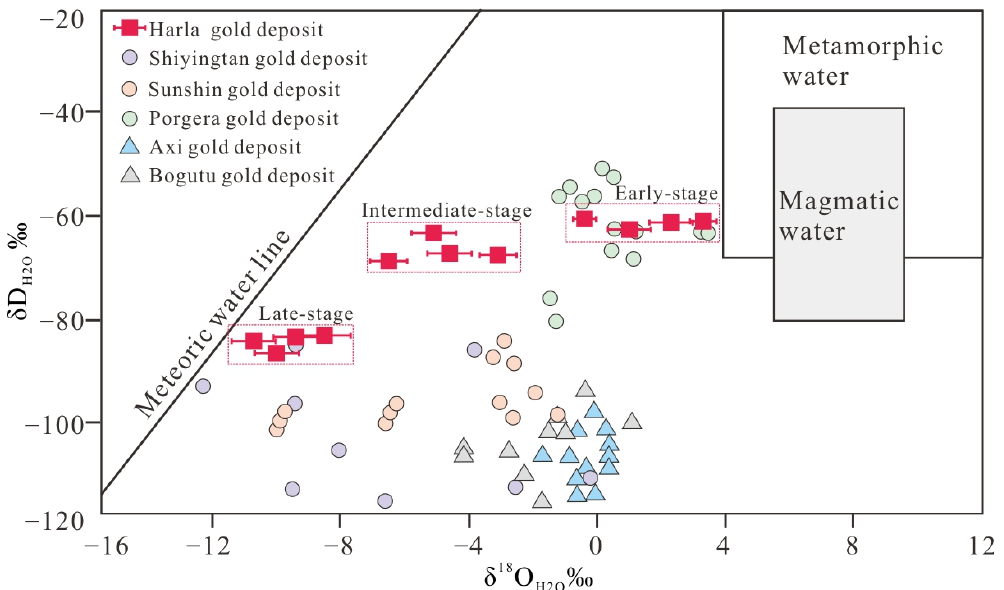
Figure 8. δ D H2O vs. δ 18 O H2O plot for FI water from different stages of the Harla gold deposit compared with other typical gold deposits. Fields for magmatic water, metamorphic water, and meteoric water line are from Taylor [25]. Data for other gold deposits are from Zhang et al. [26], Kim et al. [27], Ronacher et al. [28], Sun et al. [29], and Zhai et al. [30]. Carbon isotopic data for FI water in the Harla gold deposit show narrow variation values ( − 8.9 to − 6.2‰), which overlap with δ C values of other typical gold deposits in the ETO (Figure 9) [31–33], such as the Shiyingtan deposit ( δ C = − 6.75 to − 2.02‰ [32]) and the Hongshi deposit ( δ C = − 11.57 to − 5.14‰ [32]). Most carbon isotopic compositions (> − 10‰) show an inorganic carbon origin, close to pyroclastic rocks ( δ C = − 6.11‰ [33]) and mylo- nites ( δ C = − 7.93 to − 5.87‰ [32]) in the region. This indicates extensive water–rock reaction during the metallogenic process. Mineralization at the Harla deposit is believed to be closely related to the convective circulation of heated meteoric water in the wall rocks.